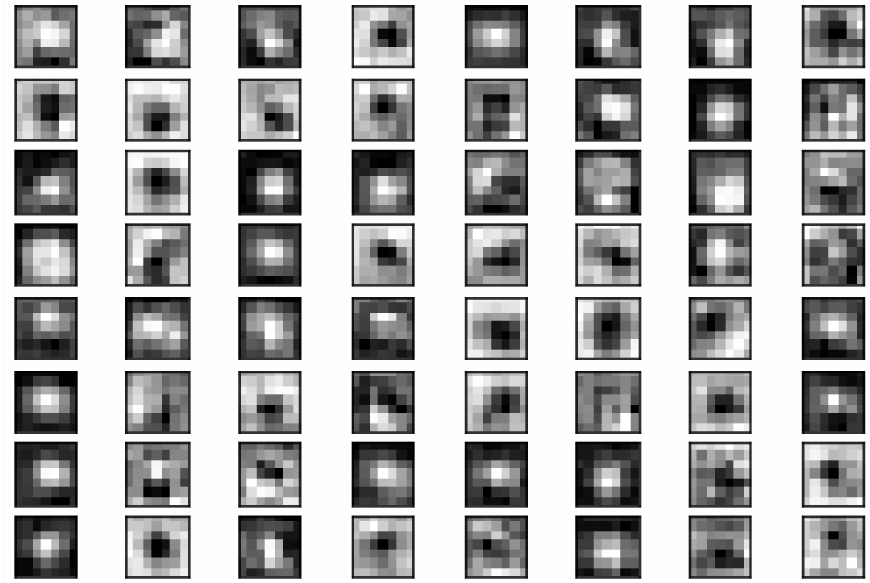
Figure 13. Feature map from last convolutional layer (Conv 4) of the ResNet50V2